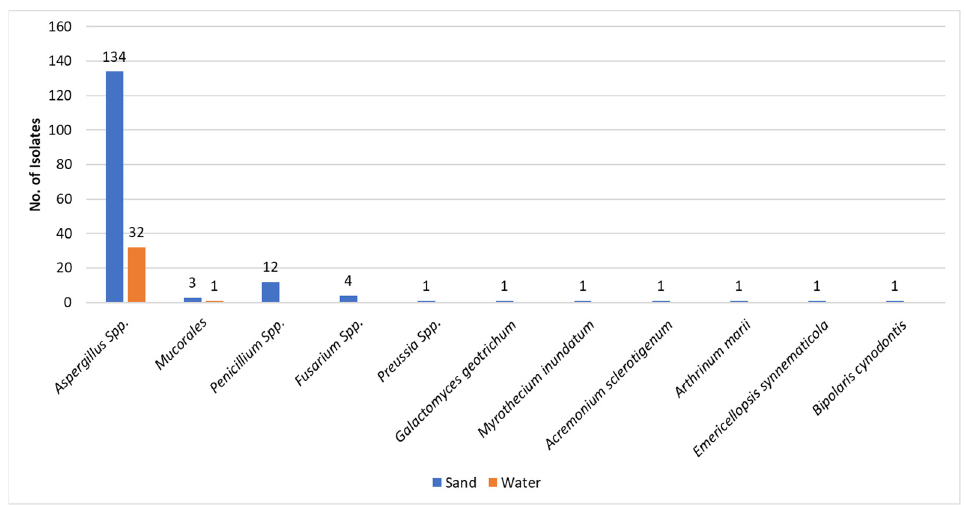
Figure 2. Number of isolates/yeast species in sand and water. The Y-axis represents the number of isolates.